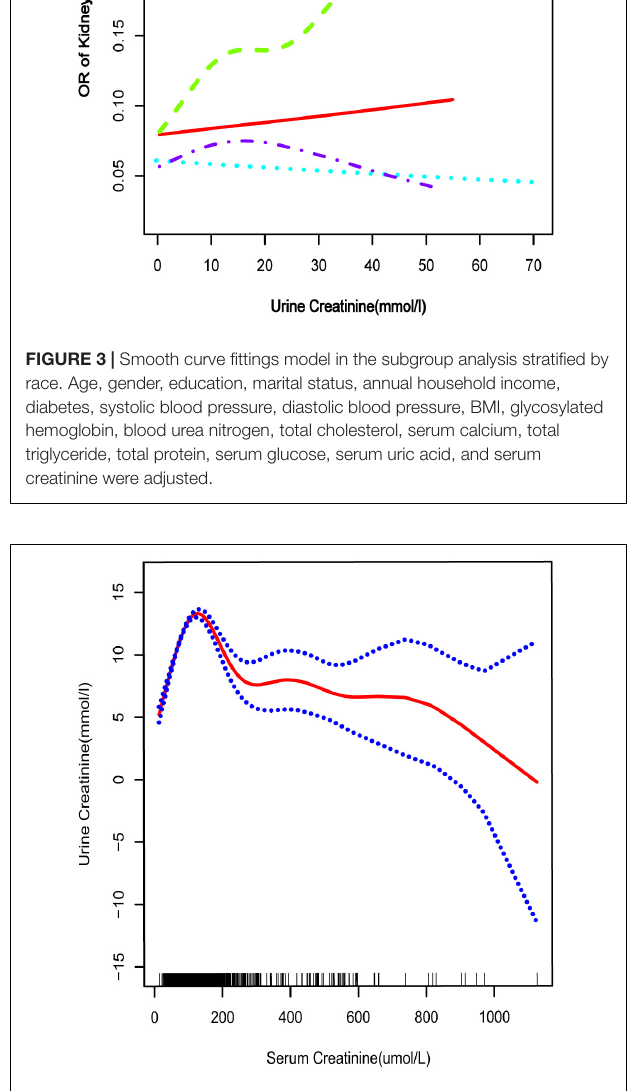
FIGURE 2 | Smooth curve fittings model in the subgroup analysis stratified by gender. Age, race, education, marital status, annual household income, diabetes, systolic blood pressure, diastolic blood pressure, BMI, glycosylated hemoglobin, blood urea nitrogen, total cholesterol, serum calcium, total triglyceride, total protein, serum glucose, serum uric acid, and serum creatinine were adjusted.